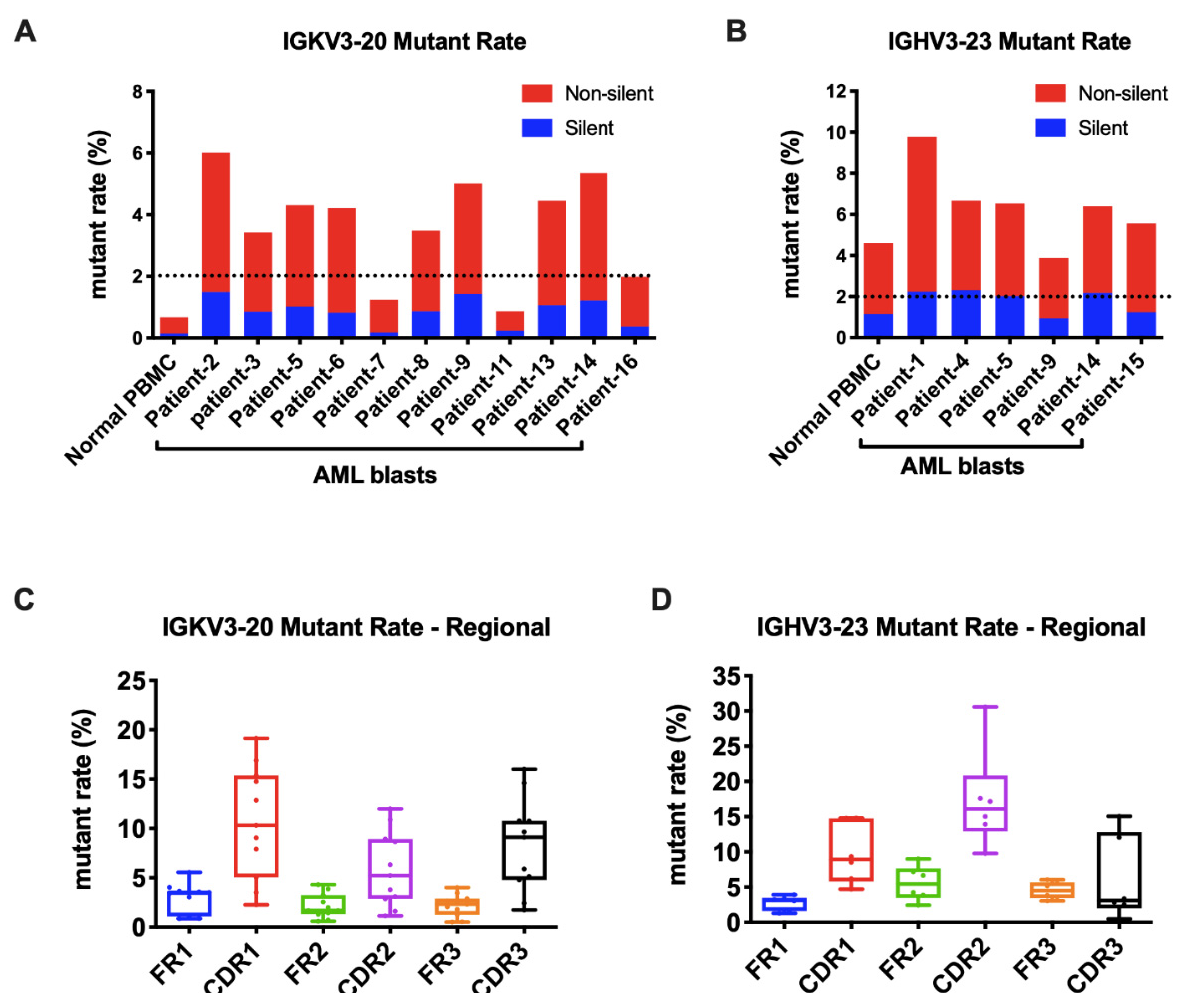
Figure 5. AML-derived Igs undergo somatic hypermutations. ( A ) The mutation rates of V κ 3-20 in normal PBMCs and AML blasts. A cut-off rate of 2% is shown by the dotted line. ( B ) The mutation rates of IGHV3-23 in normal PBMCs and AML blasts. A cut-off rate of 2% is shown by the dotted line. ( C ) The mutation rates of framework regions (FRs) and complementary determining regions (CDRs) in AML-derived IGKV3-20. ( D ) The mutation rates of FRs and CDRs in AML-derived IGHV3-23. There were three kinds of gene mutations defined by their different influence on amino acid (AA) sequences: silence mutation (AA not changed), missense mutation (AA changed), and nonsense mutation (stop codon introduced). Most mutations in V κ were non-silent (Figures 5A and S2A). We further explored the impact of nucleotide (nt) replacement on the AA sequences in myeloblasts. Surprisingly, we found that all five most frequently mutated points in IGKV3-20 were at the second site of the serine (S) codon (Figure 6B). The main substitutions were threonine (T) and asparagine (N) (Figure 6C), indicating that the AA modification changes may affect functions of AML-Ig κ . In contrast, mutation hotspots in IGKV2D-28 did not affect identical AA residues (Figure